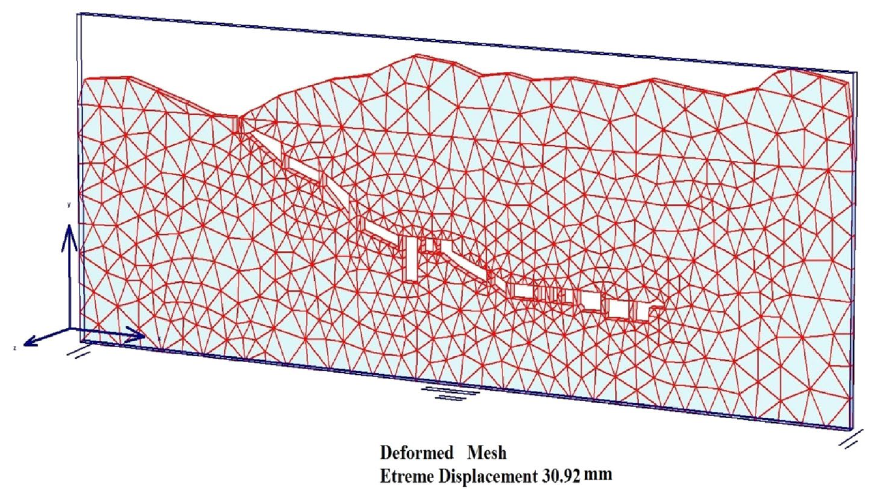
Fig. 3. Deformed Mesh with extreme displacement 3.92